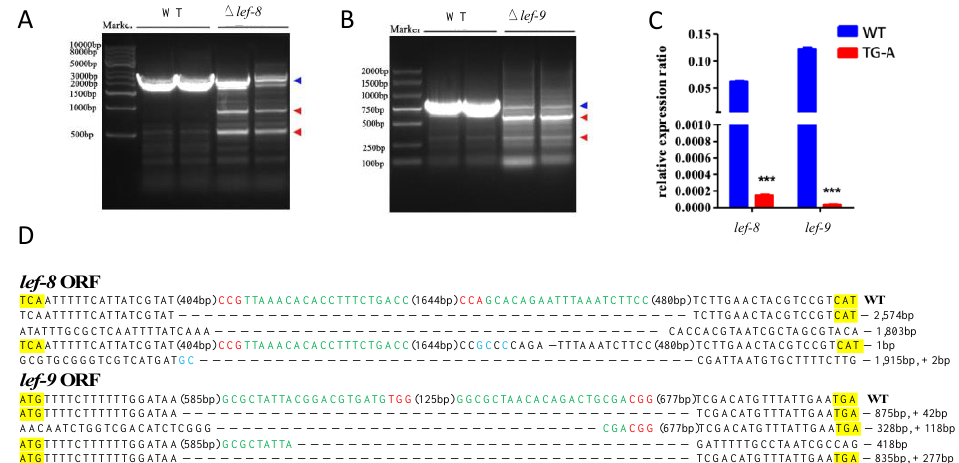
Figure 4. The BmNPV genome is edited in transgenic silkworms. ( A , B ) PCR-based amplification of regions in lef8 ( A ) and lef9 ( B ) in TG-A and WT silkworms infected with 10 6 OBs/larva. The blue arrowheads indicate the complete full-length gene sequence and red arrowheads indicate the truncated edited gene sequence. ( C ) The lef8 and lef9 mRNA levels in TG-A and WT silkworms infected with 10 6 OBs/larva. mRNA levels were normalized to those of Bmrp49 . ( D ) Various fragment deletions were detected in TG-A silkworms. The red sequence indicates the PAM sequence. For each gene, the open reading frame in the WT sequence is shown at the top, with the start and stop codons highlighted in yellow, the target sites in green, the PAM sequences in red, and the inserted bases in blue. The net change in length caused by each indel mutation is given to the right of the sequence (+, insertion; − , deletion).